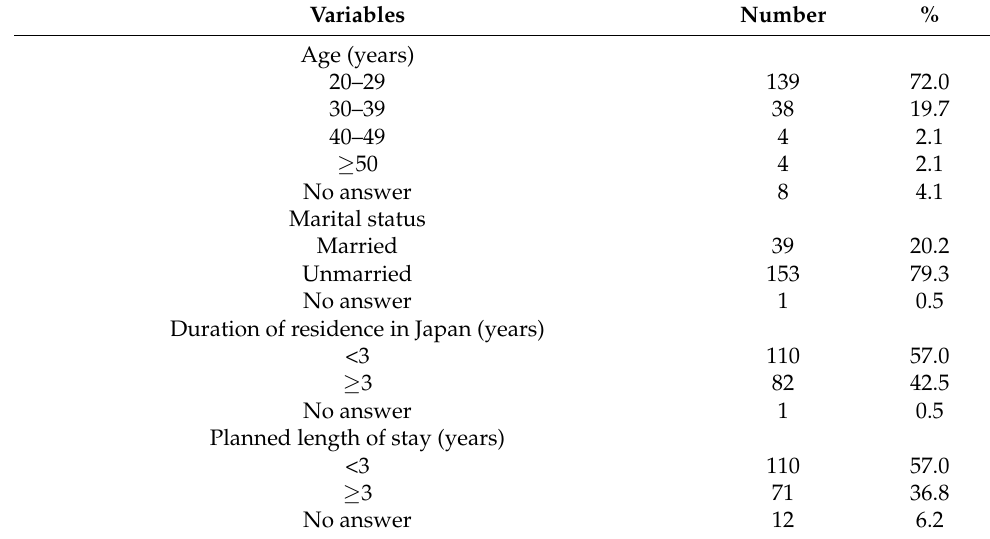
Table 1. Descriptive characteristics of participants (n =